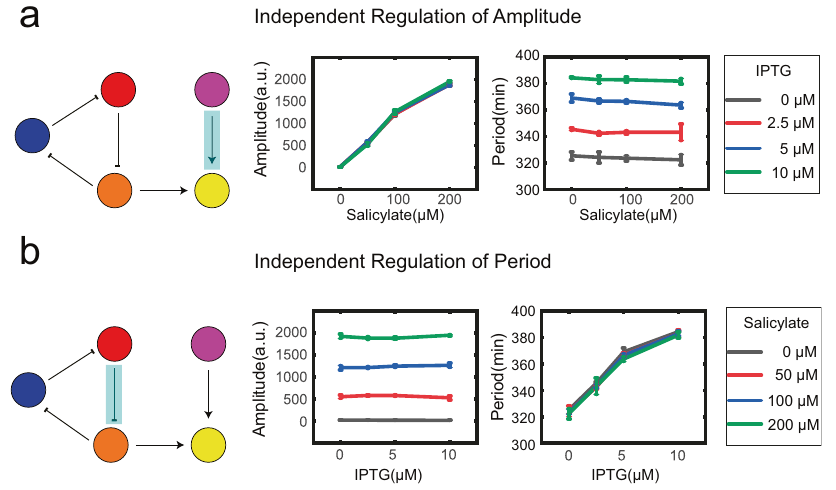
Fig. 4 Independent regulation of amplitude and period. a Independent regulation of amplitude. Sixteen groups of single cells were shown as four curves vary with different salicylate concentrations. The four curves respectively represent the IPTG concentration of 0, 2.5, 5, and 10 μ M. b Independent regulation of amplitude. The same sixteen groups of single cells were shown as four curves vary with different IPTG concentrations. The four curves respectively represent the salicylate concentration of 0, 50, 100, and 200 μ M. Each group had the results of three independent experiments and each experiment had over 100 single cells. The data point were calculated from the average of the three experiments and the error bars were calculated from the SD of the average of the three